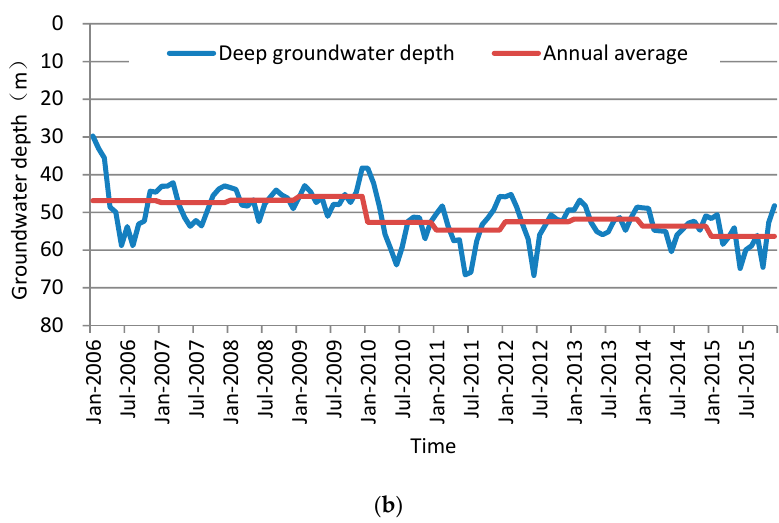
Figure 6. Variation of groundwater depth from 2006 to 2015 in Cheng’an County: ( a ) Shallow; ( b ) Deep.